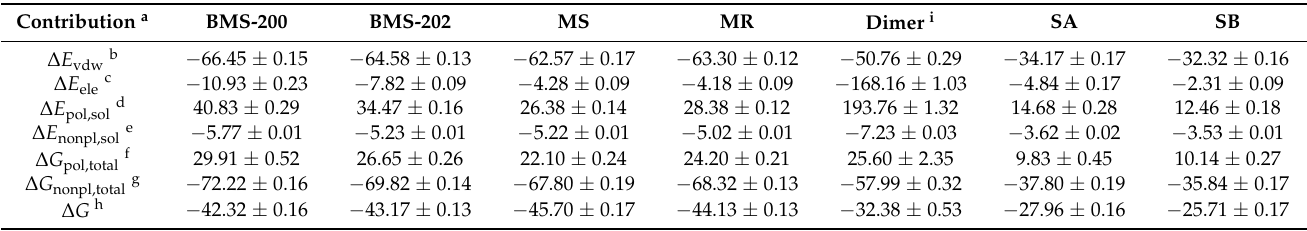
Table 2. The binding free energies of the systems evaluated by the MM-PBSA